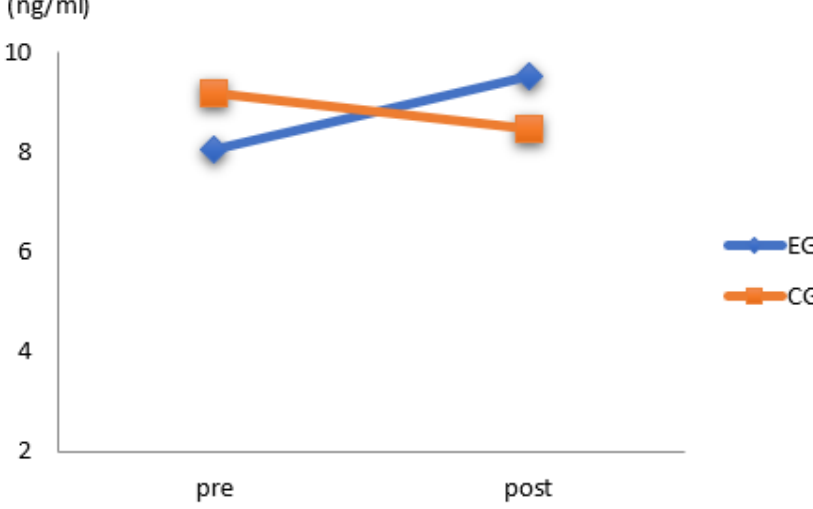
Figure 1. Osteocalcin changes.